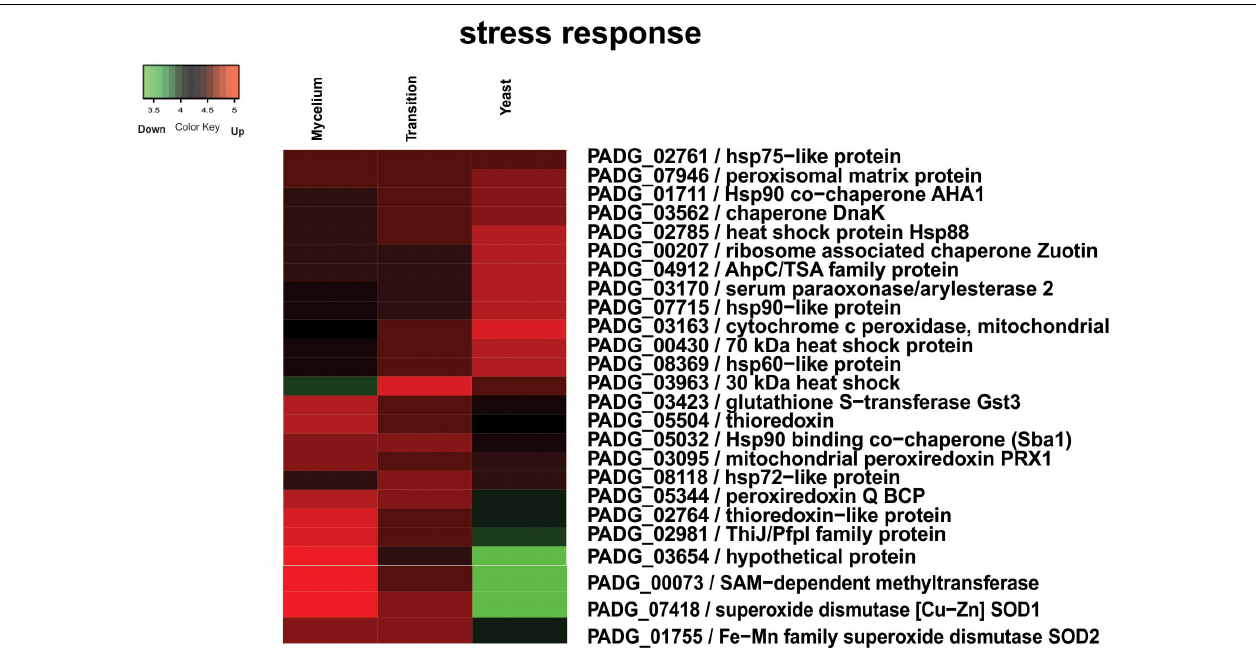
FIGURE 6 | Heatmap of HSPs induced and repressed in yeast cells compared to mycelia and mycelia-to-yeast transition. The color scale shows the mean of abundance of differentially expressed proteins ( p -value ≤ 0.05). Functional categories were obtained by manual search in the annotation database Pedant (http://pedant.gsf.de/) on MIPS that provides a tool to search the Functional Categories (Funcat 2.0). Red represents significantly higher expression and green represents a significantly low level of